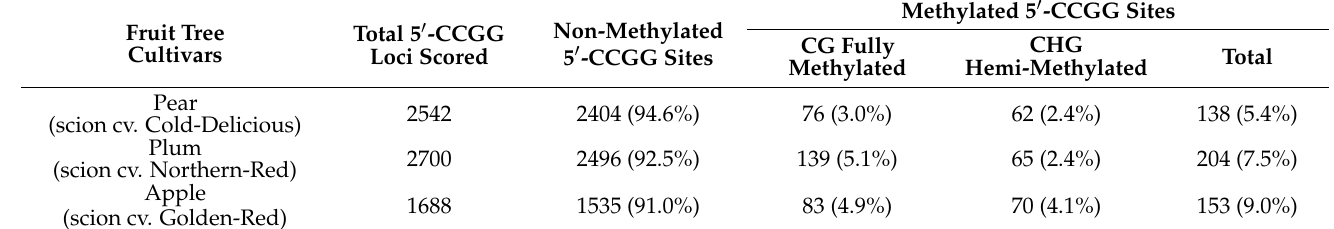
Table 1. Number of CCGG loci analyzed by MSAP in the three fruit tree scion cultivars. Fruit Tree Cultivars